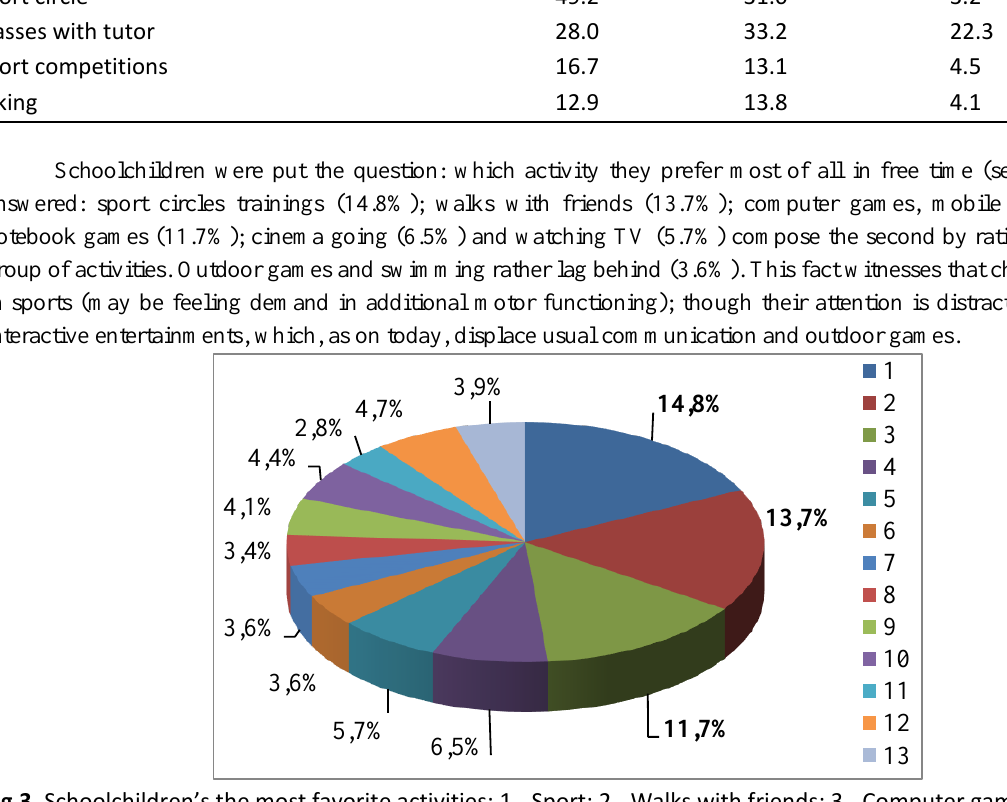
Fig.3. Schoolchildren’s the most favorite activities: 1 - Sport; 2 - Walks with friends; 3 - Computer games; 4